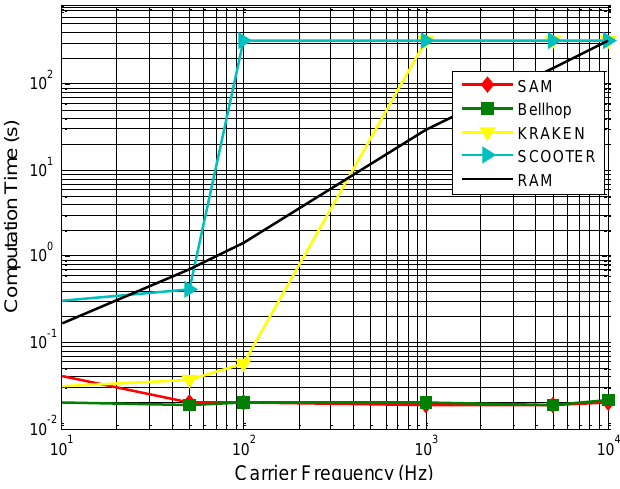
Figure 11. Computational time vs. carrier frequency.